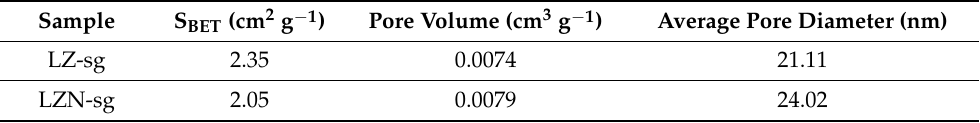
Table 3. Summary of porosity measurements of La 2 Zr 2-x Ni x O 7 pyrochlores.